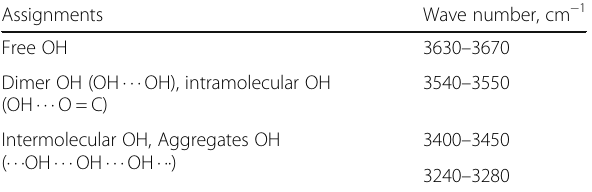
Table 2 Assignments of considered IR bands in PHEMA Assignments